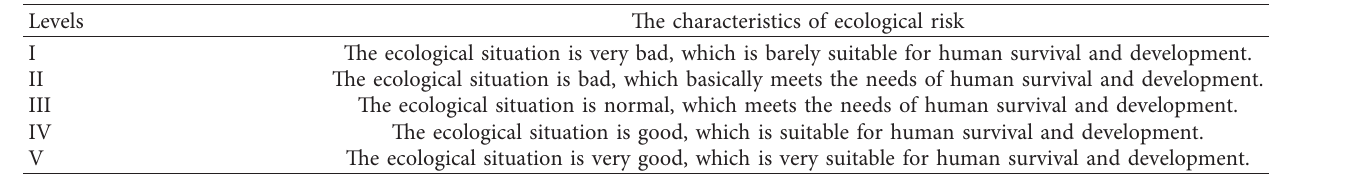
Table 2: Characteristics of ecological risk.